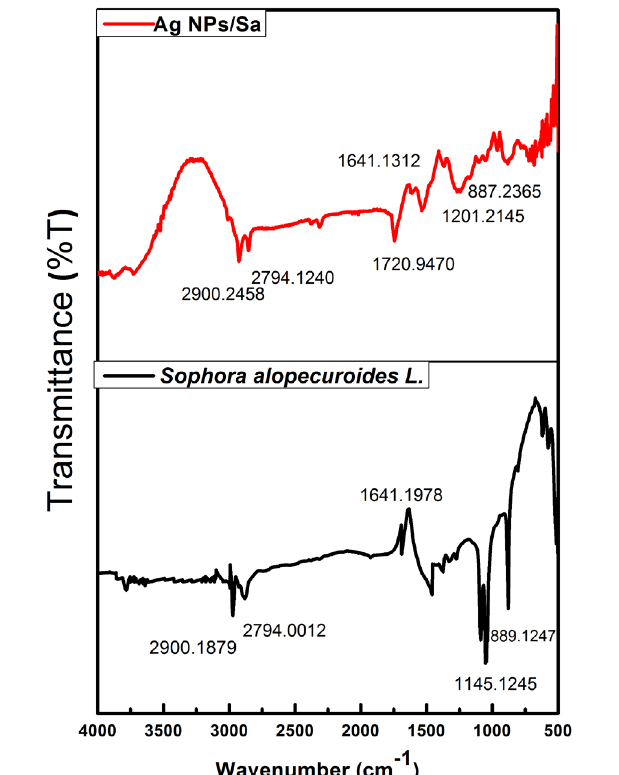
FIGURE 2 - FT-IR spectra of S. alopecuroides L. and Ag